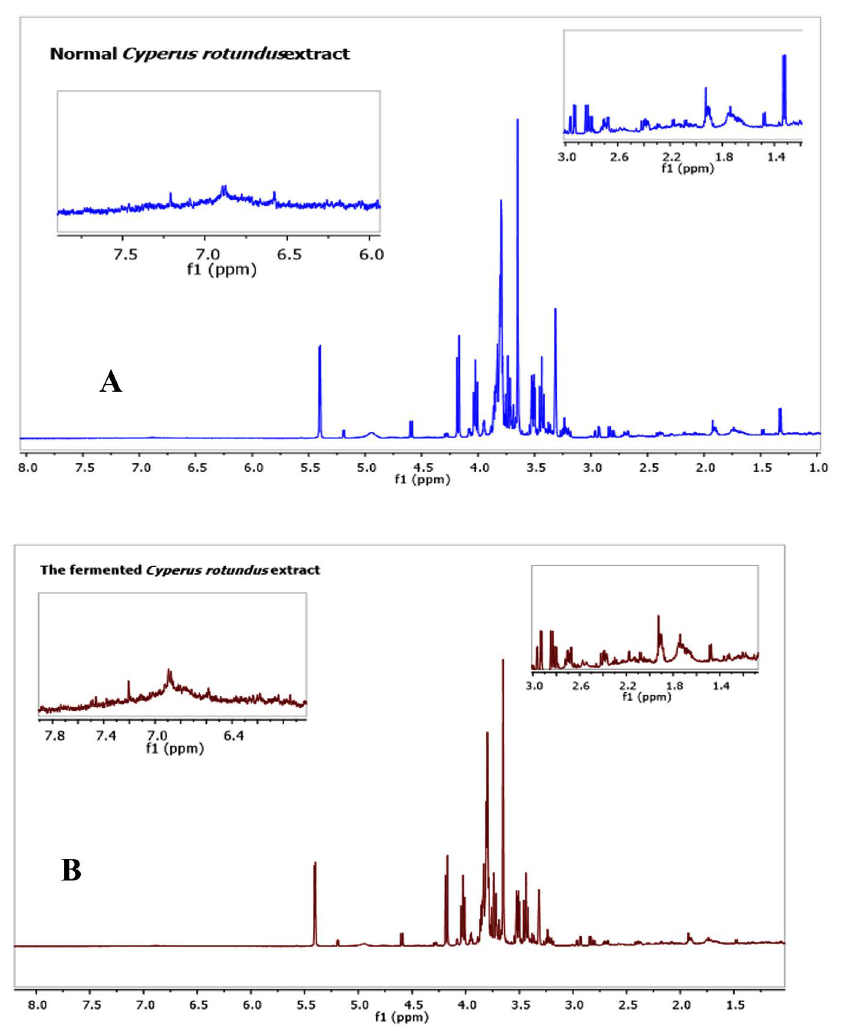
Fig. 3. 1 H-NMR full spectra of δ 1.0 to 8.0 ppm. (A) The fermented. (B) The non-fermented C. rotundus